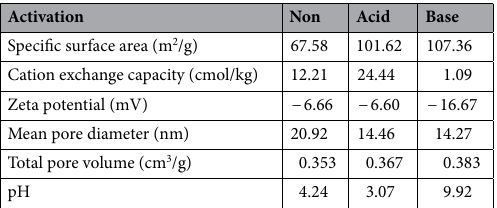
Table 1. The physico-chemical properties of each activated opaline mudstone.